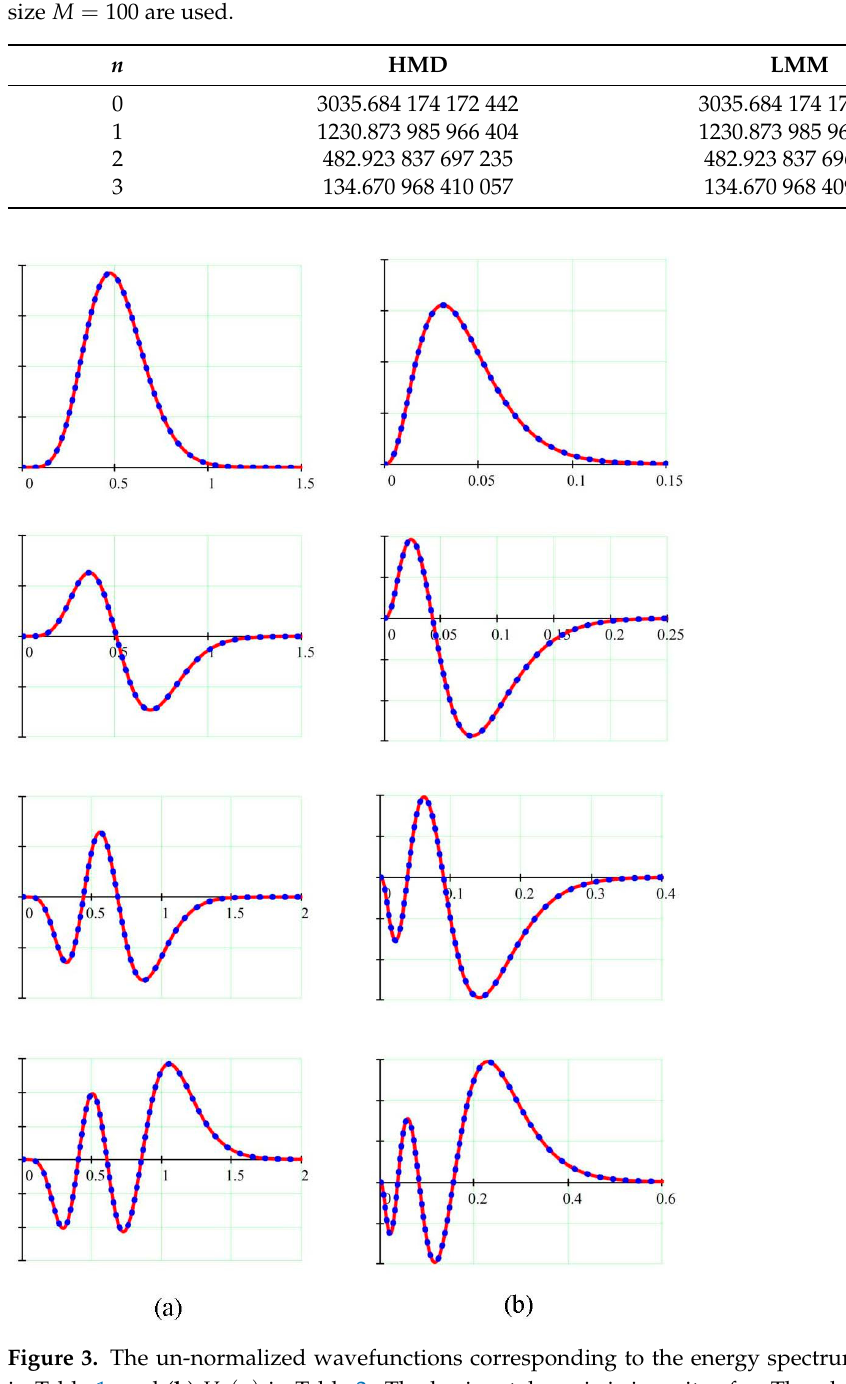
Figure 3. The un-normalized wavefunctions corresponding to the energy spectrum of: ( a ) V I ( x ) in Table 1, and ( b ) V II ( x ) in Table 2. The horizontal x -axis is in units of a . The plots from top to bottom are ψ 0 ( x ) , . . . , ψ 4 ( x ) . The red solid trace is the TRA finite-series approximation, whereas the superimposed blue dotted trace is the result of a robust numerical routine that gives a highly accurate evaluation of the wavefunction. See text for details.